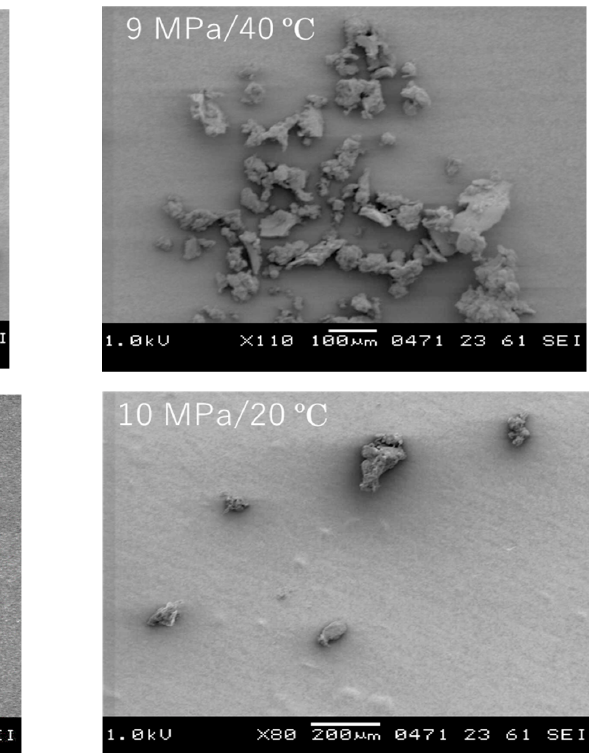
Figure 3. SEM images of ( a ) crude Lf; ( b ) Lf encapsulated shellac microcapsules produced by PGSS process of scCO 2 solutions at 40 °C and 10 MPa. ( c ) Particle size distribution of the Lf encapsulated shellac microcapsules produced by PGSS process of scCO 2 solutions at 40 °C and 10 MPa.